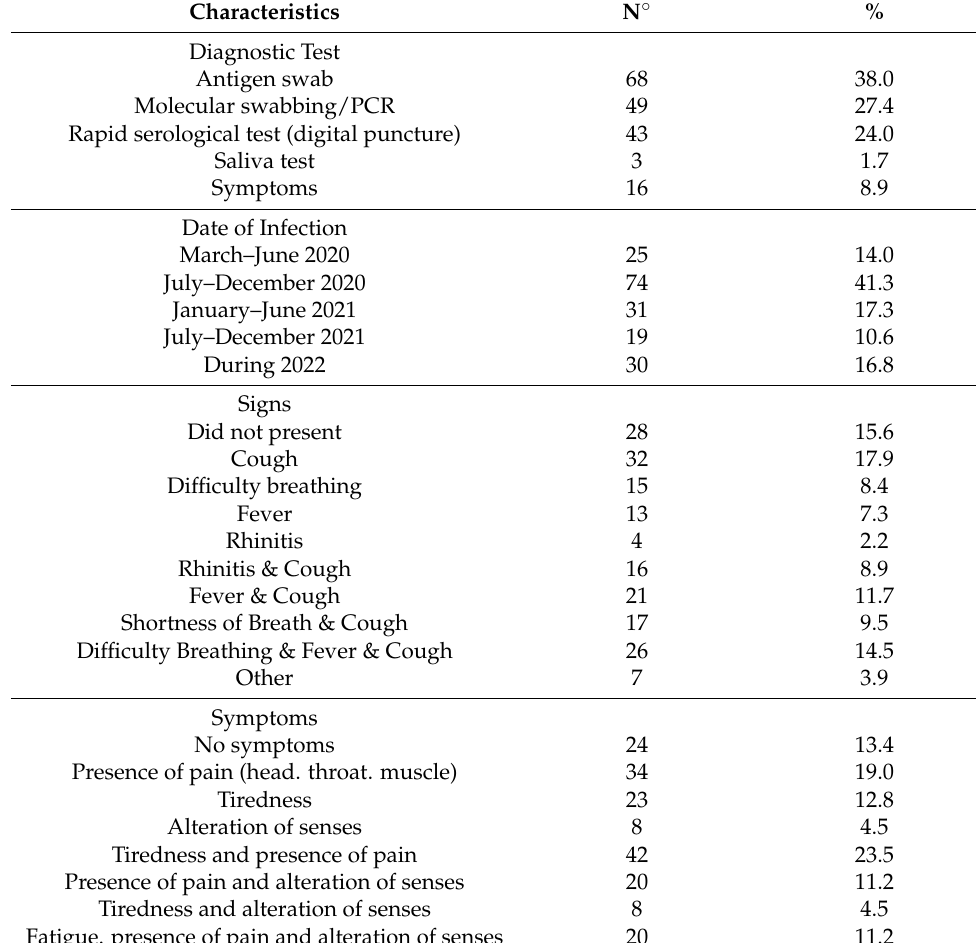
Table 3. Clinical characteristics and adverse effects of SARS-CoV-2 in infected dentists.